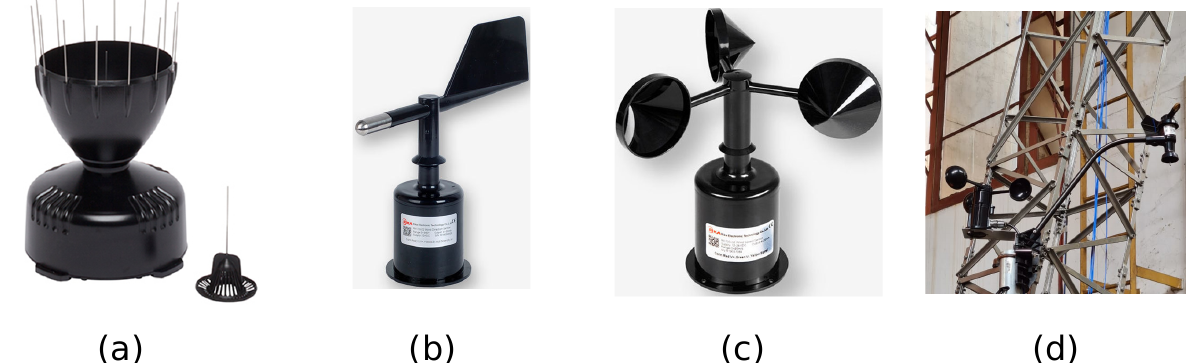
Figure 10. The weather station sensing elements: ( a ) rain gauge, ( b ) wind direction, ( c ) wind speed, and installed sensing elements on the mockup tower, and ( d ) all sensors installed in the